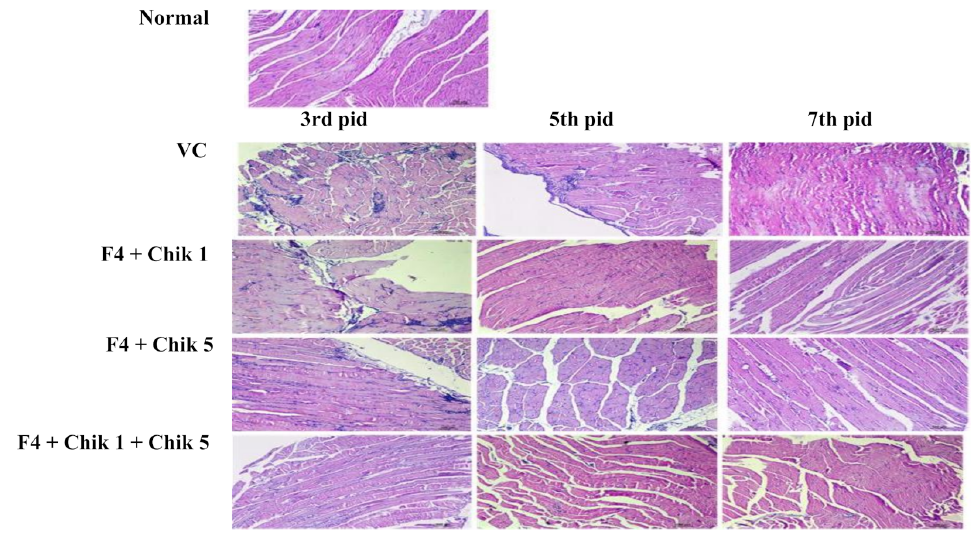
Figure 8. Histopathological changes in mouse muscle tissues after chikungunya infection and siRNA- loaded F4-delivery-system